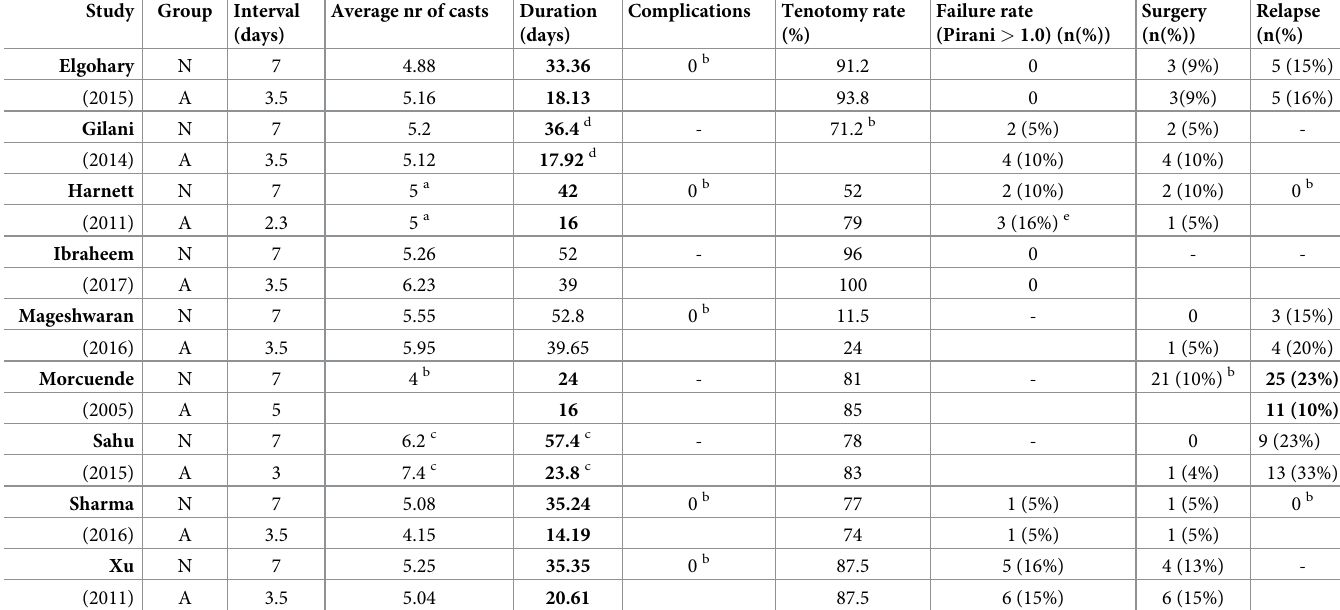
Table 4. Extracted data from the selected papers. Study Group Interval (days)